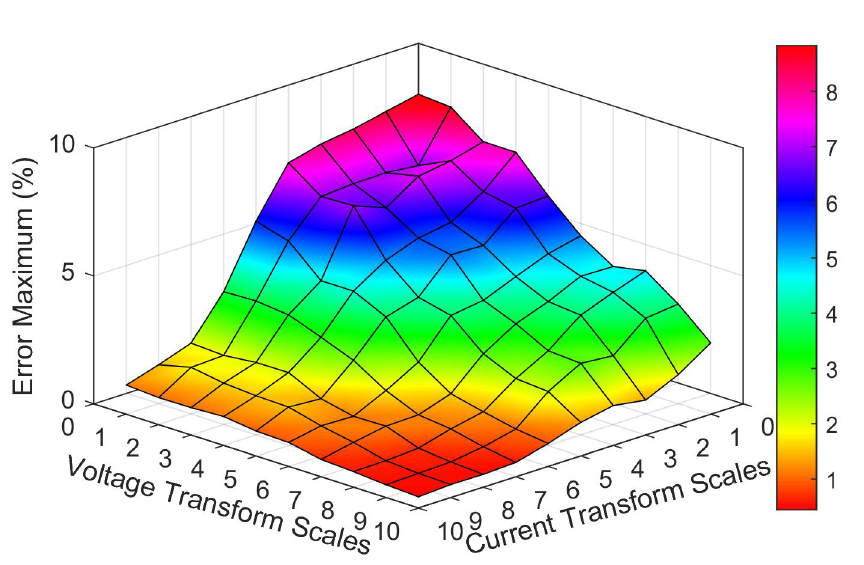
Figure 13. Maximum estimation error for different transformation scales (UDDS).